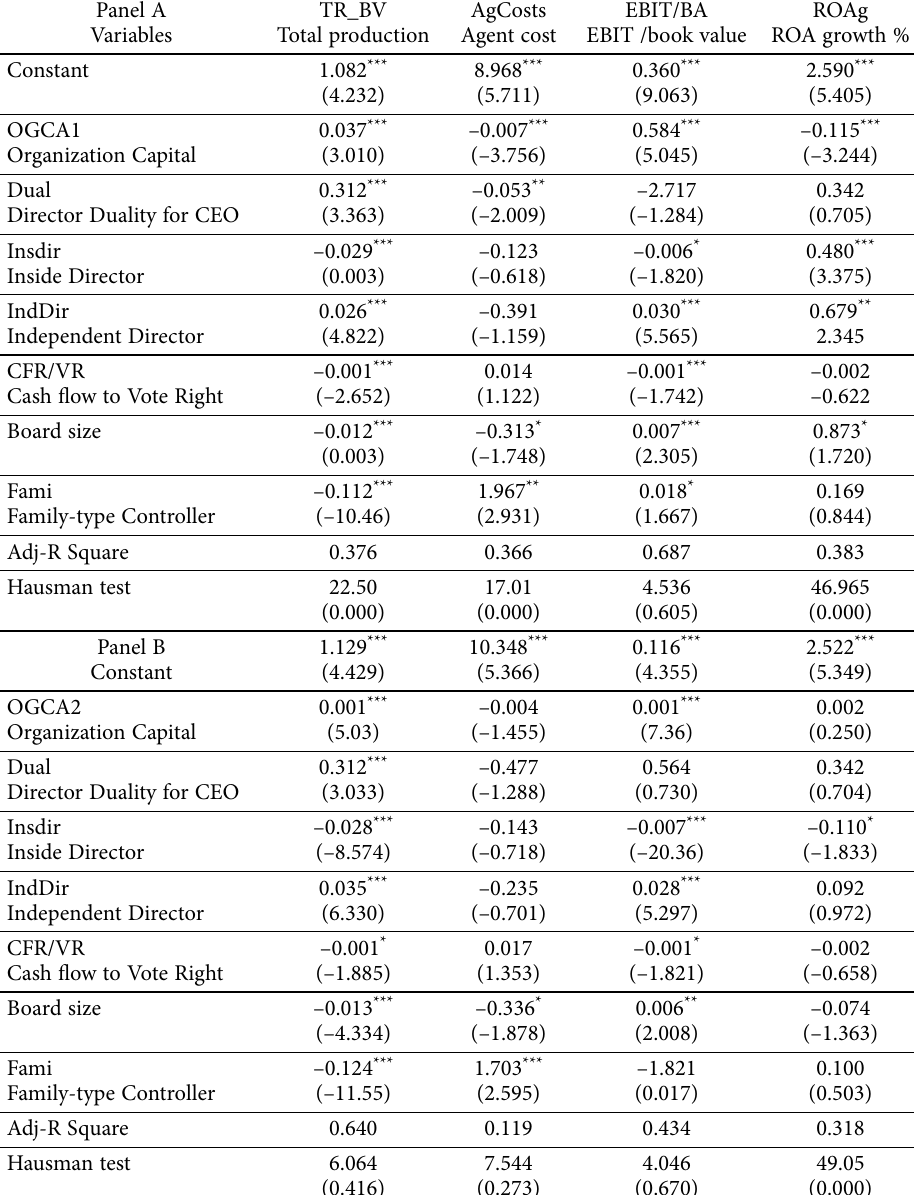
Table 4. Board function, organization capital and corporate